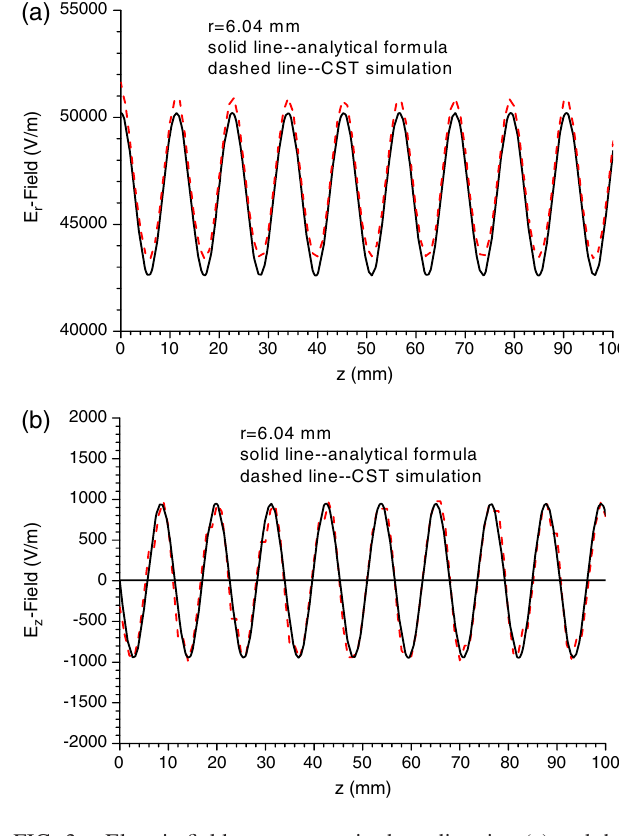
FIG. 3. Electric field components in the r direction (a) and the z direction (b) versus the longitudinal position z at a location of r ¼ 6 : 04 mm , where l ¼ 0 : 3 mm , h ¼ 8 mm , p ¼ 11 : 32 mm , r in ¼ 5 : 6 mm , and V 0 ¼ 100 V